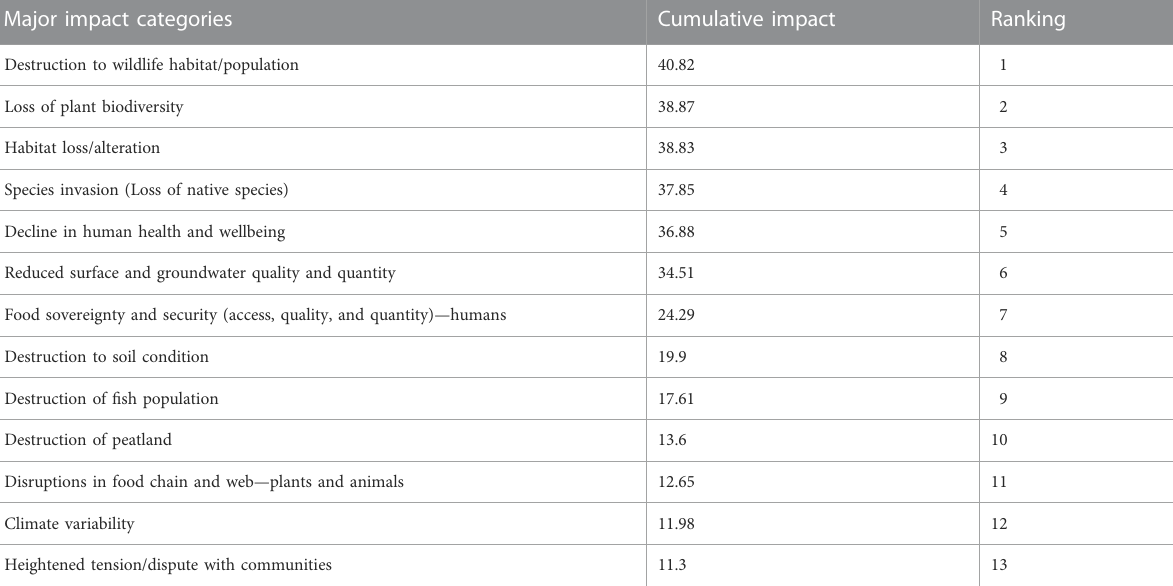
TABLE 6 Cumulative impacts of each of the major impacts